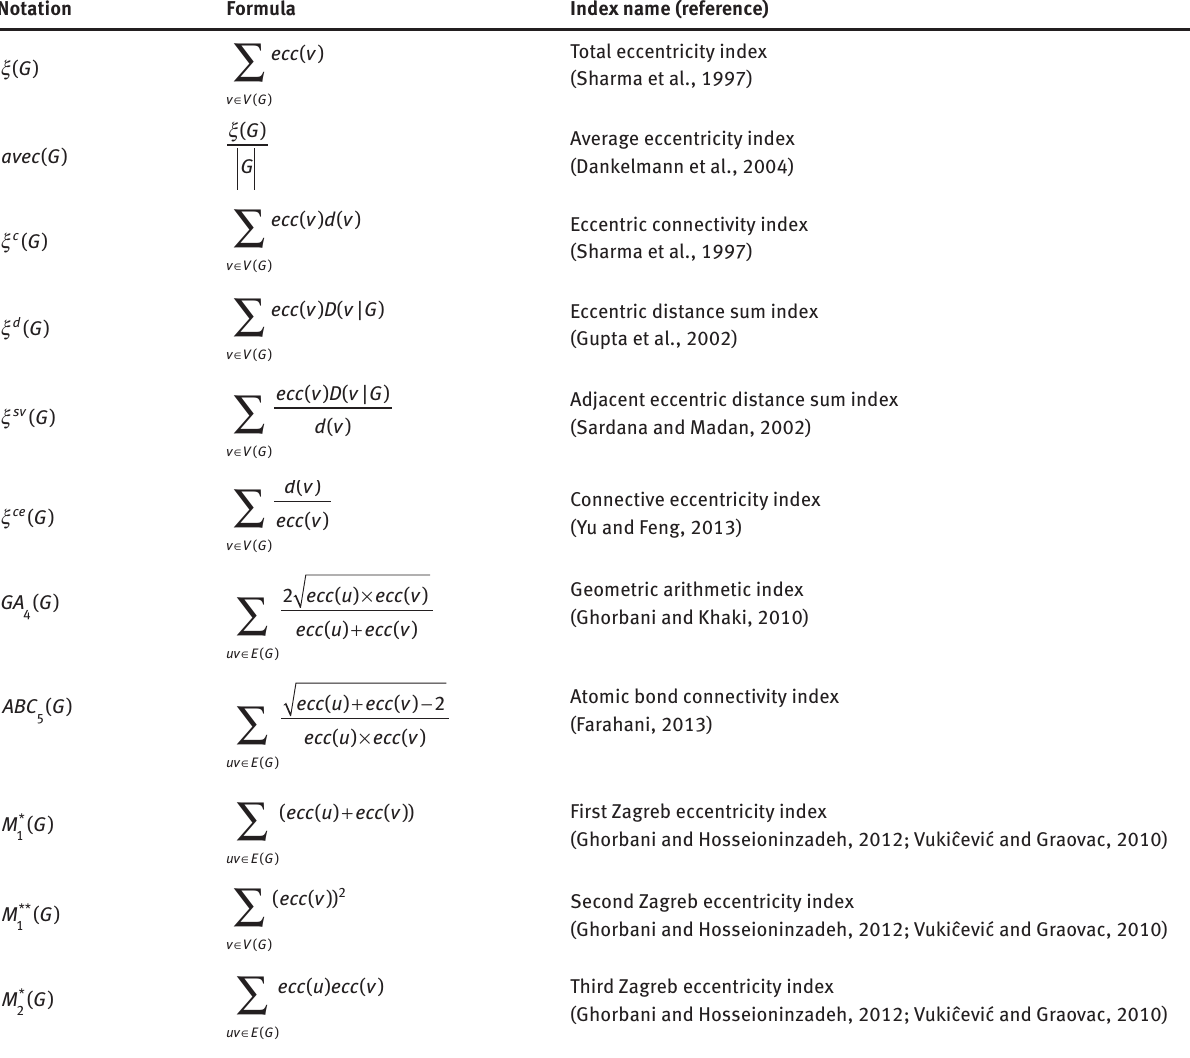
Table 1: Eccentricity based topological